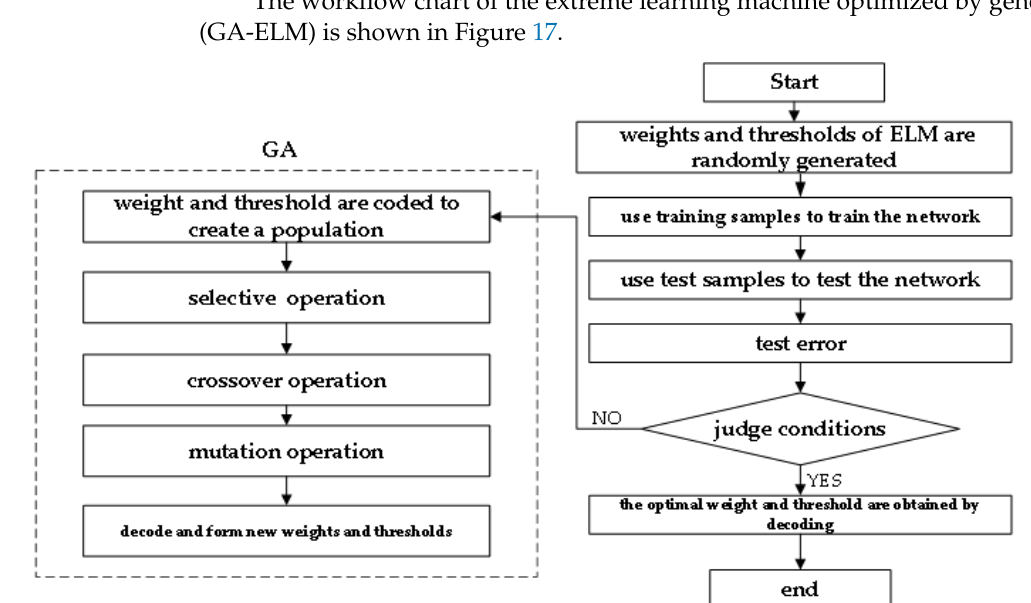
Figure 17. Workflow chart of GA-ELM mode.